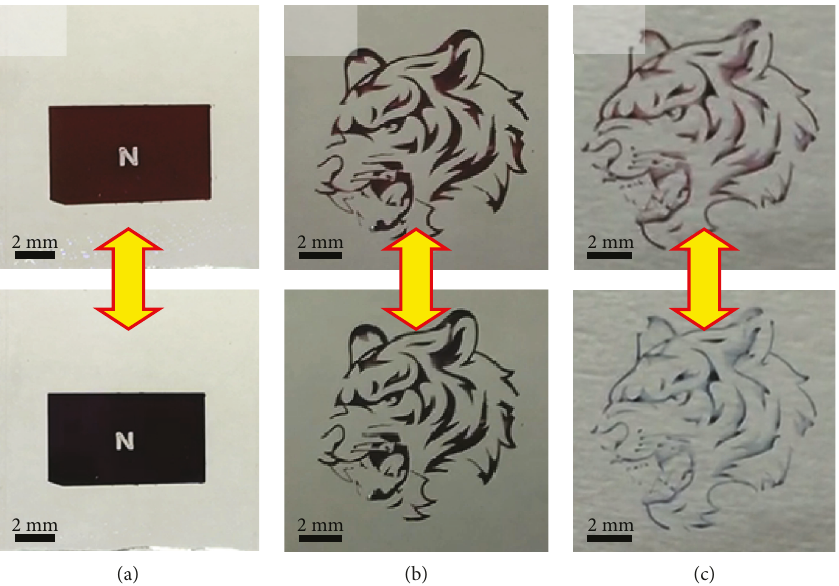
Figure 4: Photographs of the EC display devices with (a) negatively patterned P3HT layer at a concentration of 3.00wt%, (b) positively patterned P3HT layer at a concentration of 3.00wt%, and (c) positively patterned P3HT layers at a concentration of 1.00wt%. All devices were fabricated using chloroform as a solvent. Changes in colors of the P3HT layers were clearly observed according to the reversible oxidation (upper: red) and reduction (lower: blue) reactions in the electrolyte solution.